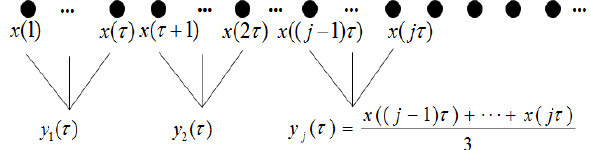
Figure 1. The coarse-grained process of time series for scale factor τ . 2. The FE of each coarse-grained time series can be computed according to Equations (1)–(9) and MFE is expressed by Equation (11) as a function of scale factor τ . This procedure is called MFE